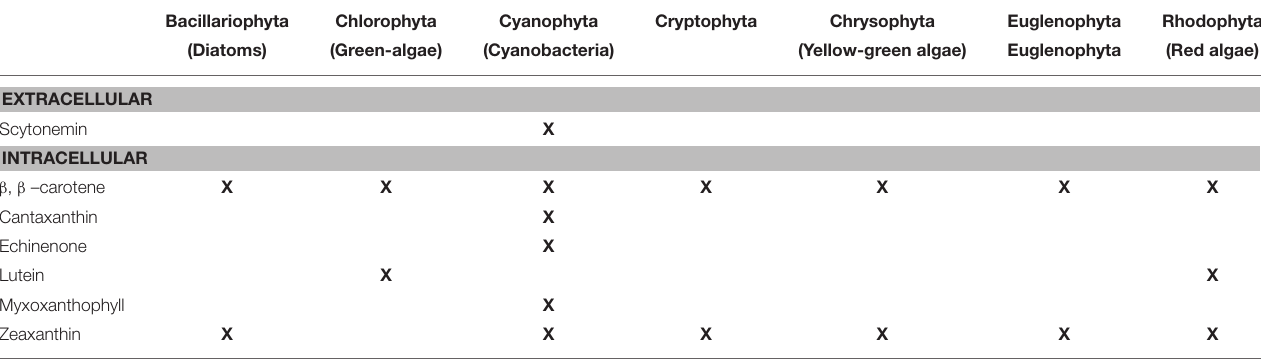
TABLE 1 | Distribution of protective carotenoids associated to flow intermittency in the different algal groups from various sources (Rowan, 1989; Jeffrey et al., 1997; Buchaca, 2009; Timoner et al.,